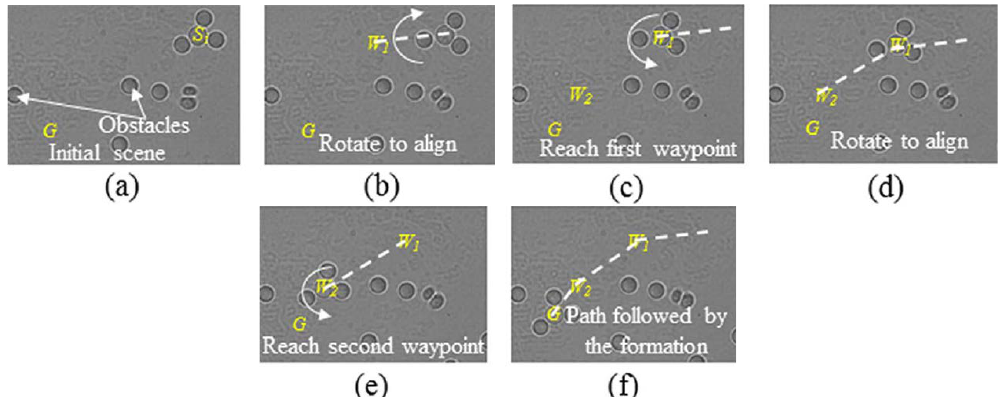
Figure 5. Transportation of a bead utilizing a three-bead gripper formation. ( a ) The initial state of the gripper S i ; ( b ) rotating maneuver; ( c ) translating maneuver to reach the waypoint W 1 ; ( d ) rotating maneuver to align it towards the waypoint W 2 ; ( e ) translating maneuver to reach the waypoint W 2 ; and ( f ) the target bead reached the desired position using a series of translating and rotating maneuvers. Reproduced with permission from [40].